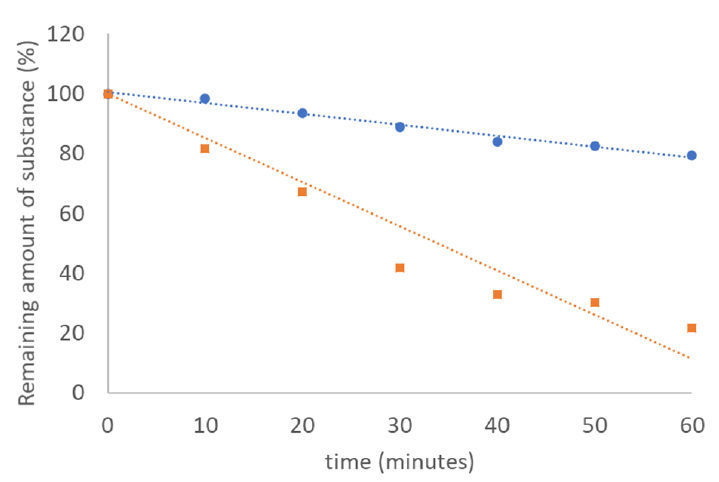
Figure 1. Comparative stability of allicin and CSA at 100 °C over a period of one hour. The relative amount of substance was determined by HPLC.